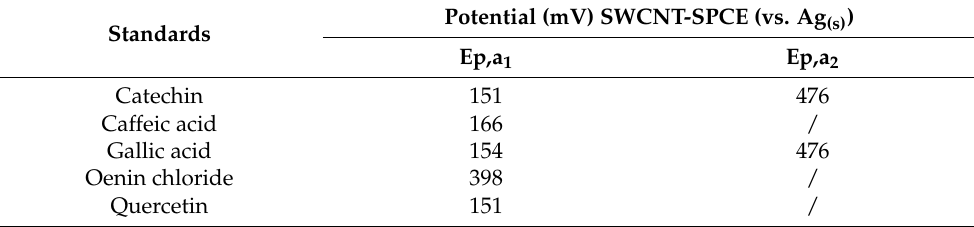
Table 3. Voltammetric peak potentials of the standard polyphenols (concentration of 0.1 mM) in model wine solution (pH 3.6) using SWCNT-SPCE. Ep,a 1 represents the potential of the first anodic peak and Ep,a 2 represents the potential of the second anodic